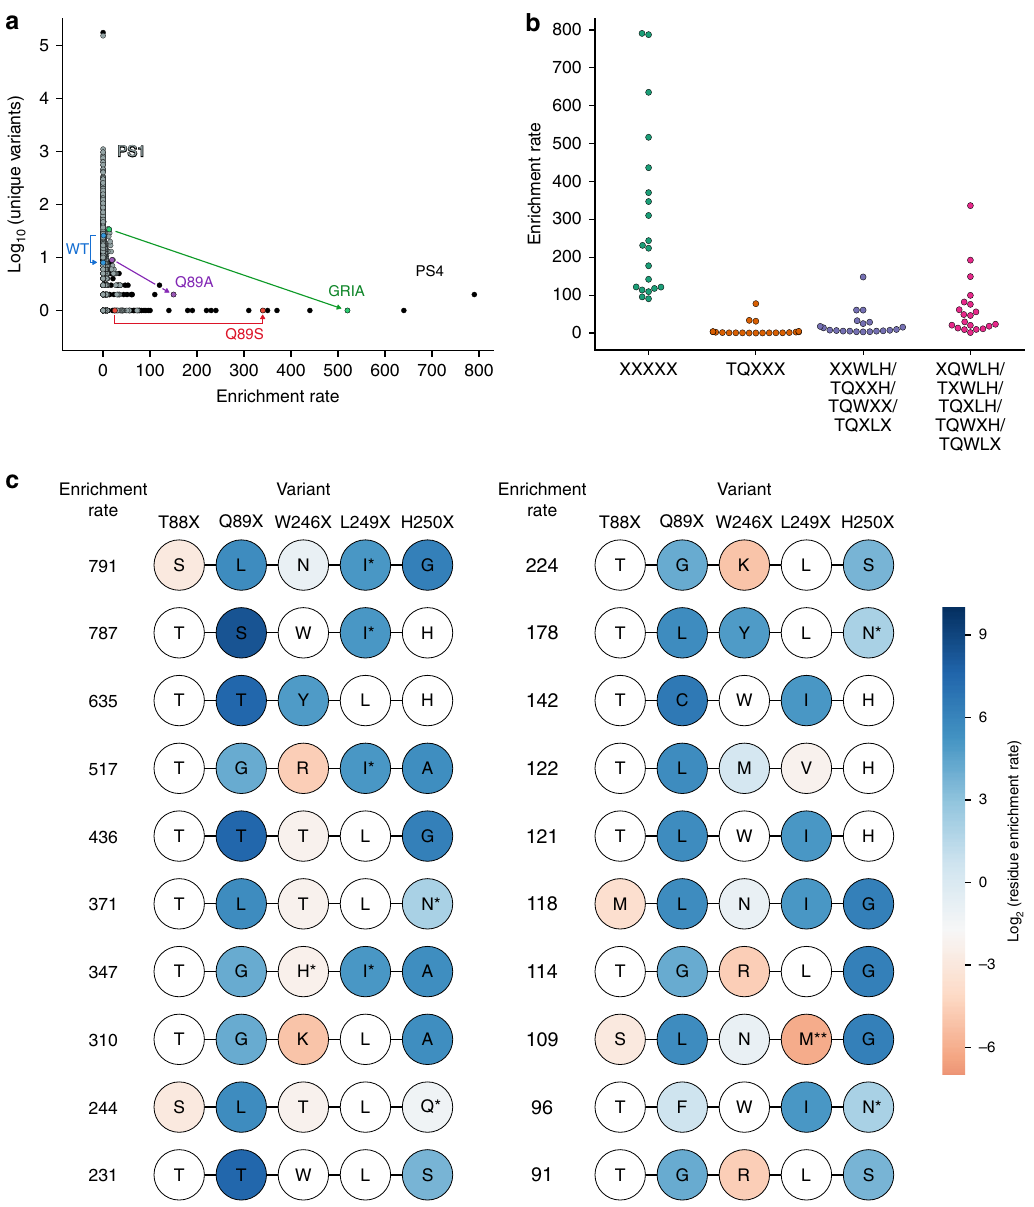
Fig. 3 BRIDGE reveals highly enriched A 2 aR variants due to epistasis between distal sites. a A histogram of the log 10 (count) of unique variants sharing a given enrichment rate demonstrates stringent, progressive enrichment of few highly enriched mutants from the naive library to the post sort (PS) 1 (gray) and PS4 (black) libraries. A small number of variants are highly enriched in PS4 (e.g., GRIA), while variants with wild-type (WT)-like behavior are not expected to be highly enriched. A positive control (Q89A) and the most abundant variant in PS4 (Q89S) also demonstrate relatively high enrichment as expected. b The top 20 variants containing at least two distal, mutated residues (XXXXX) exhibit far greater enrichment rates compared to the top 20 variants containing proximal triple (TQXXX), proximal double (e.g., XXWLH), or single (e.g., XQWLH) substitutions. c Substitutions that are deleterious in isolation are common in the 20 most highly enriched A 2 aR variants containing mutations in distal sites. Residues that are bene fi cial or deleterious as single substitutions are colored according to their log 2 -fold enrichment, where the color spectrum is centered around the wild-type enrichment rate. For example, variant SLNIG is enriched 791-fold, but the single T88S (SQWLH) substitution is deleterious. Wild-type residues have a white background. *Residue abundance between 7 and 11 in the naive library, **not detected in